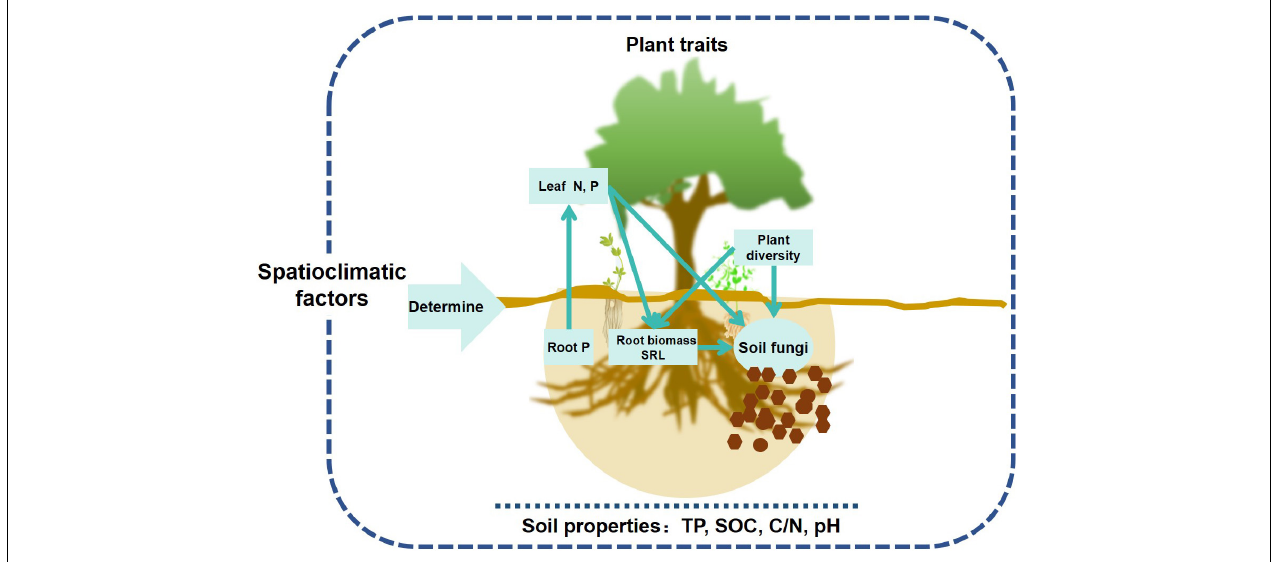
FIGURE 7 | Conceptual framework of aboveground and belowground plant traits’ effects on topsoil fungal communities in forest ecosystems across a wide range of